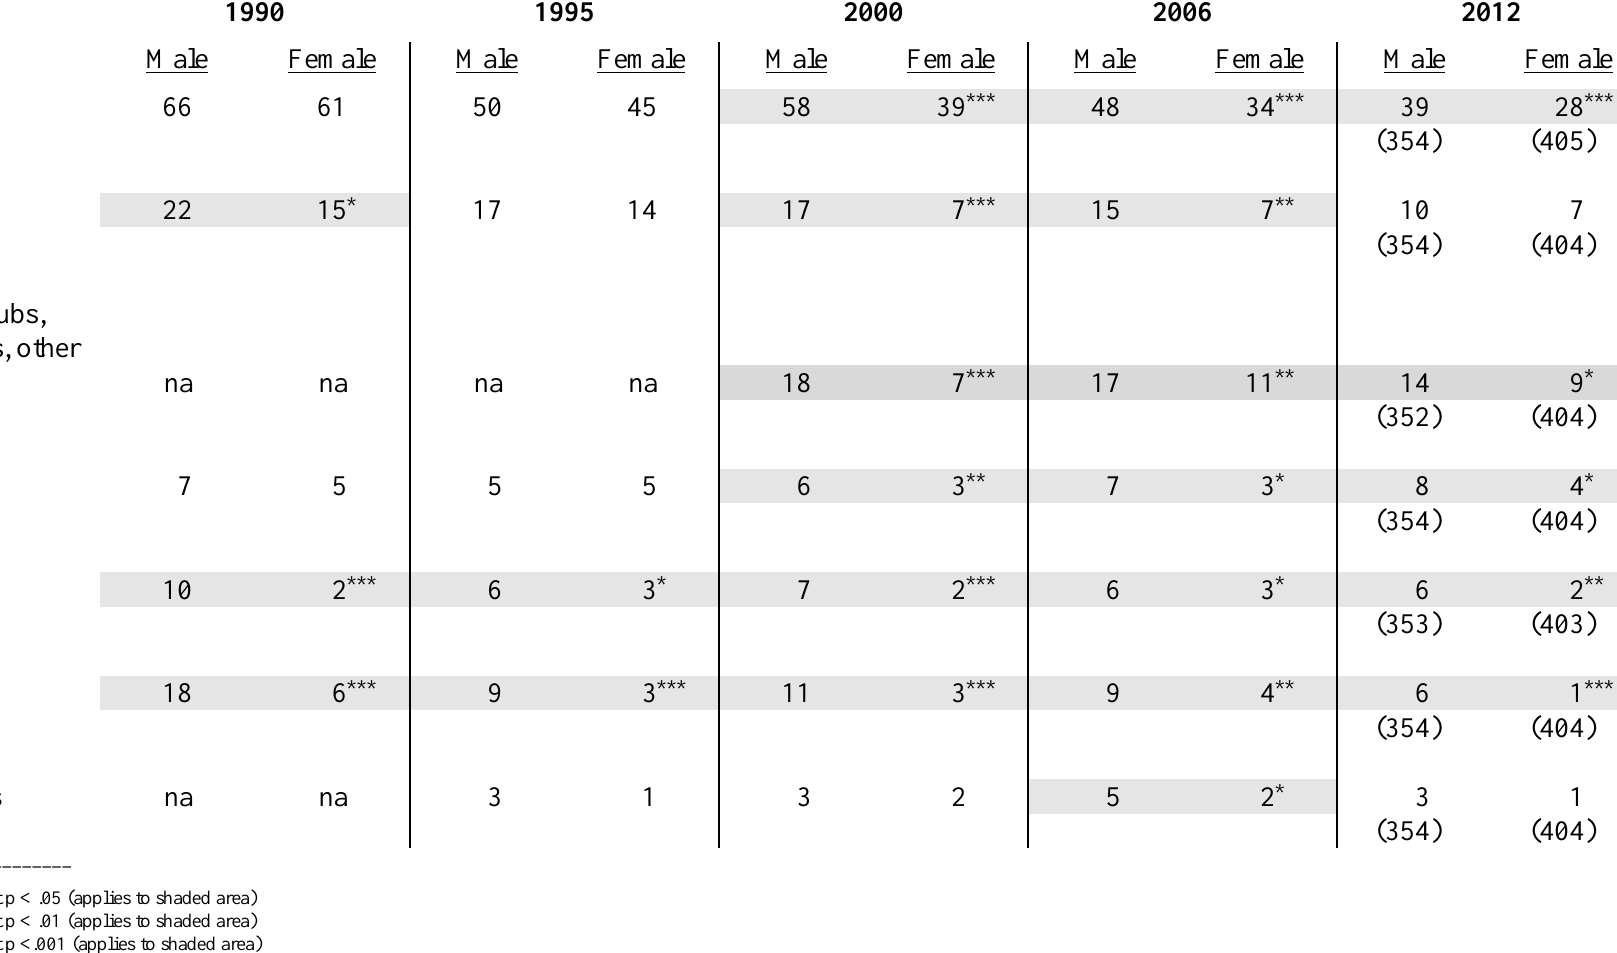
Table 27. Socializing With Other Executives (percent affirming at least monthly)